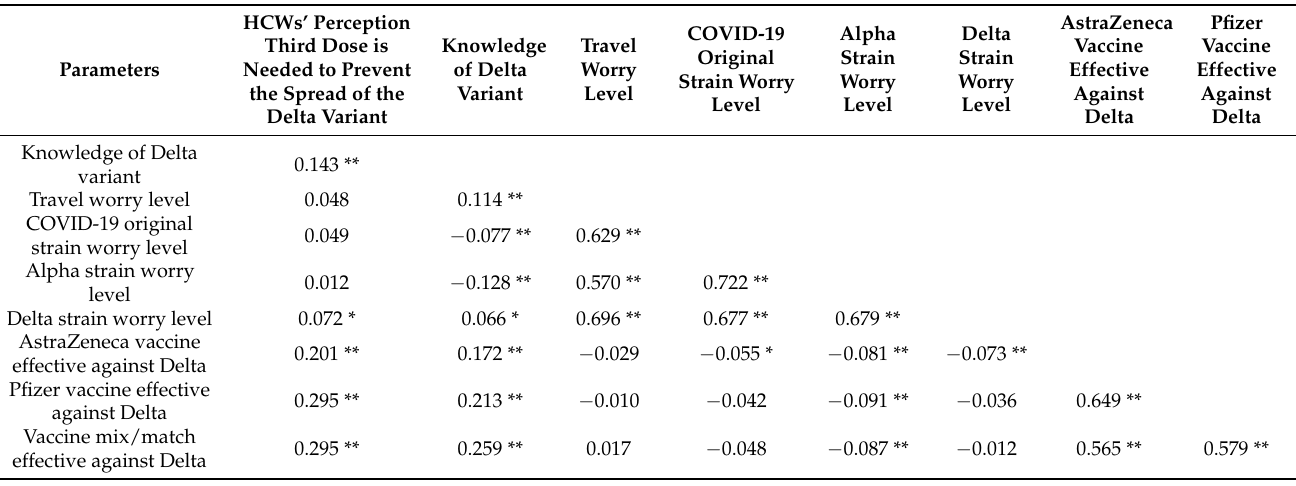
Table 7. Bivariate Pearson’s correlations between the respondents’ measured knowledge, worry level, need for a third booster dose, and perception of the effectiveness of different vaccines.